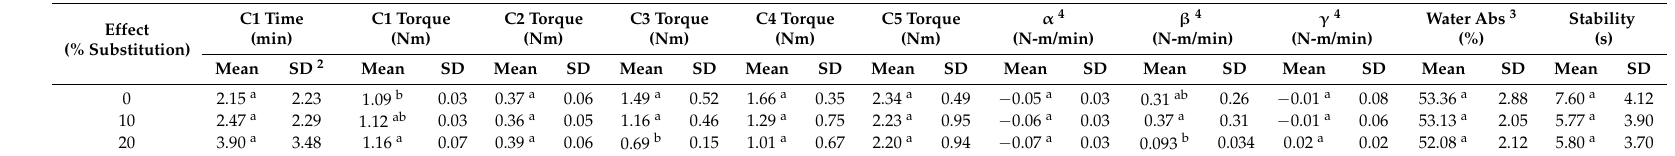
Table 6. Main effect of DDGS on Mixolab operational parameters 1 .